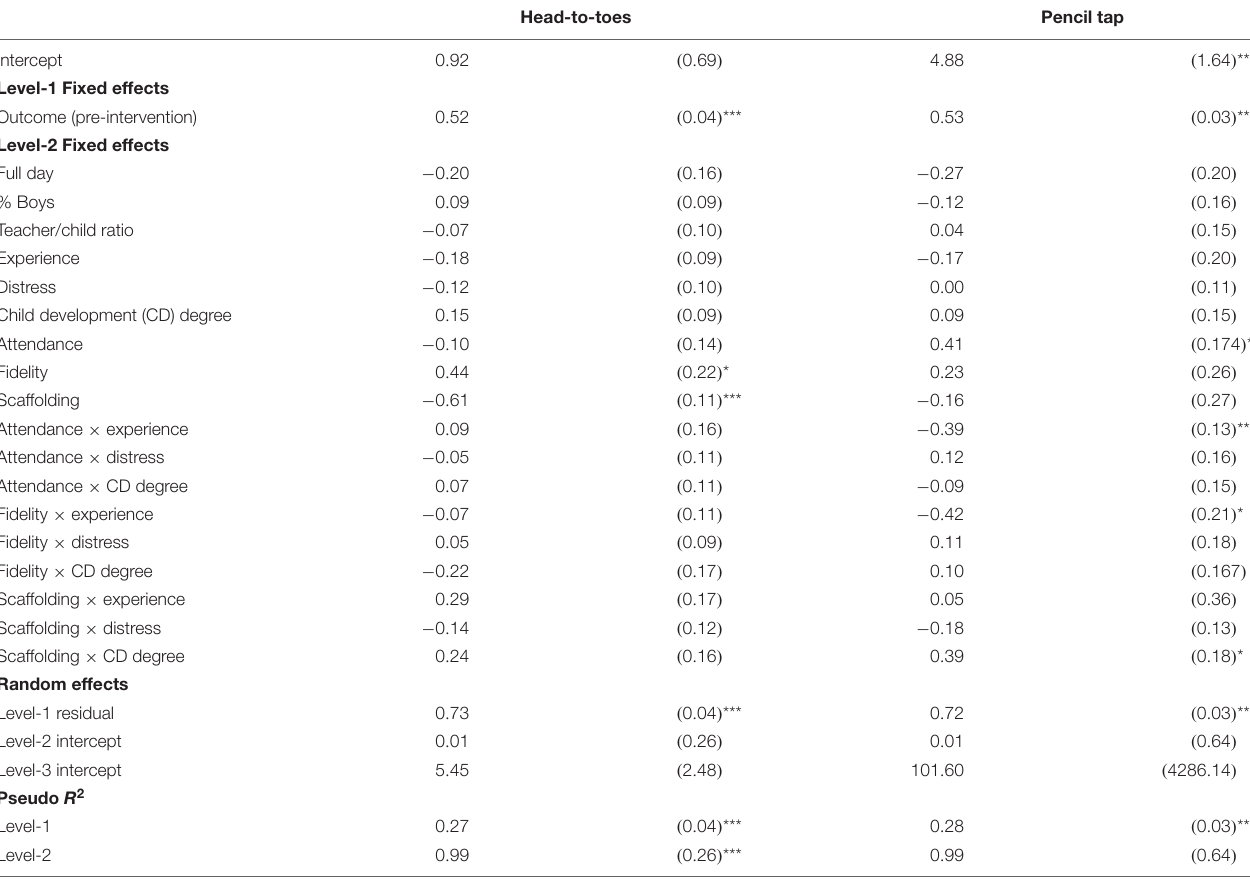
TABLE 4 | Fixed effects estimates (top) and variance estimates (bottom) for final means-as-outcomes multilevel regression model on gains in executive function.